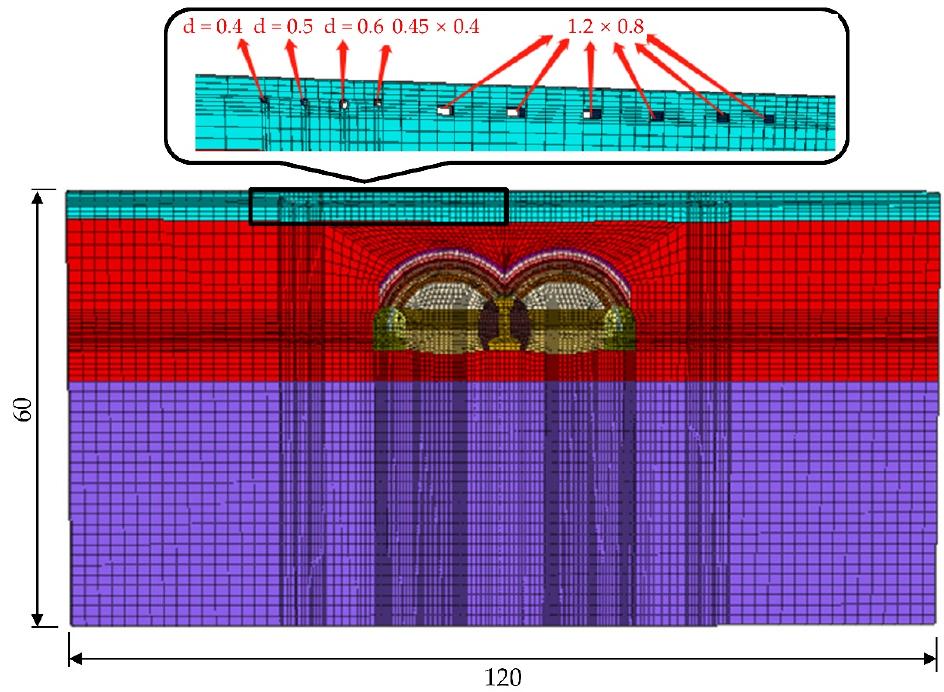
Figure 10. Numerical model of the double-arch tunnel (unit: m).